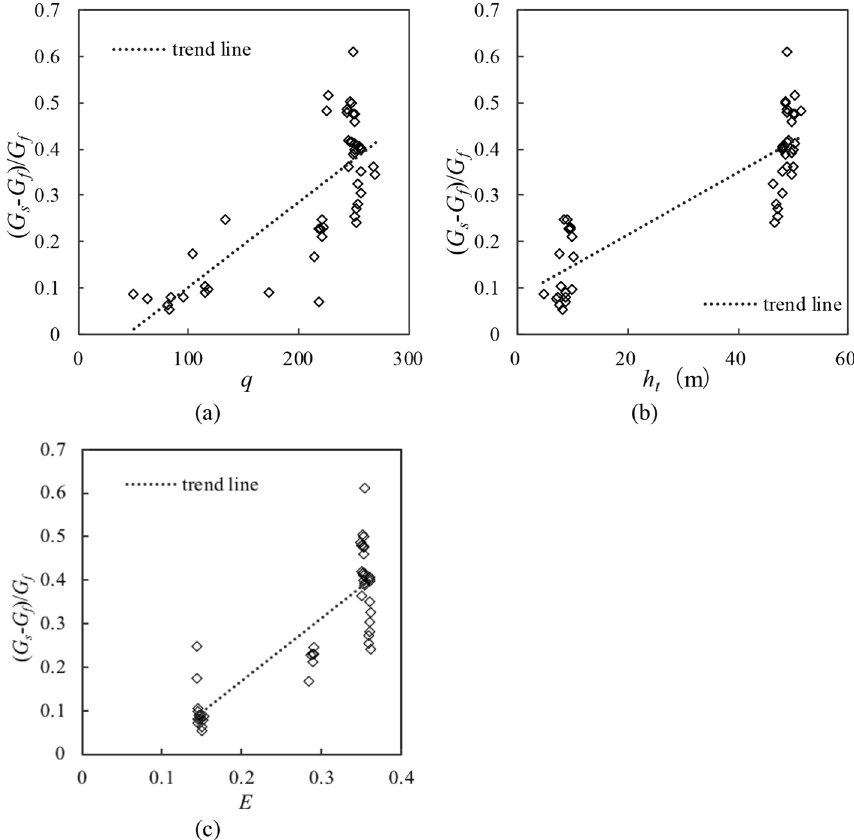
Figure 2. Relationship between ( G s − G f )/ G f and parameters in Eq. (6): ( a ) tailwater depth ( h t ); ( b ) discharge per unit width ( q ); ( c ) energy dissipation efficiency ( E ).